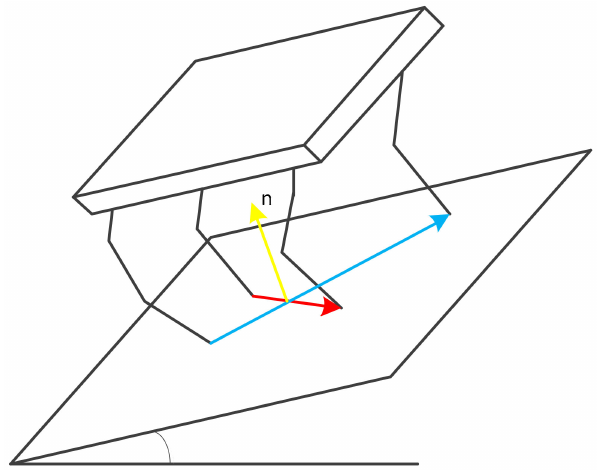
Figure 3. Figure showing the foot position vectors used for the slope